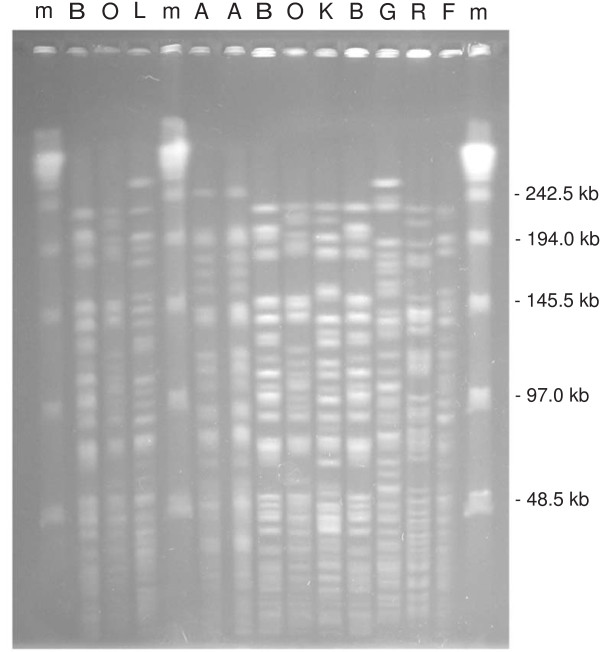
Representative PFGE profiles of P. aeruginosa isolates from neonates in the NICU. Capital letters on the top of the lanes indicate PFGE types identified; m, phage lambda DNA molecular mass markers. Sizes of lambda DNA molecular mass markers are shown on the right of the panel.